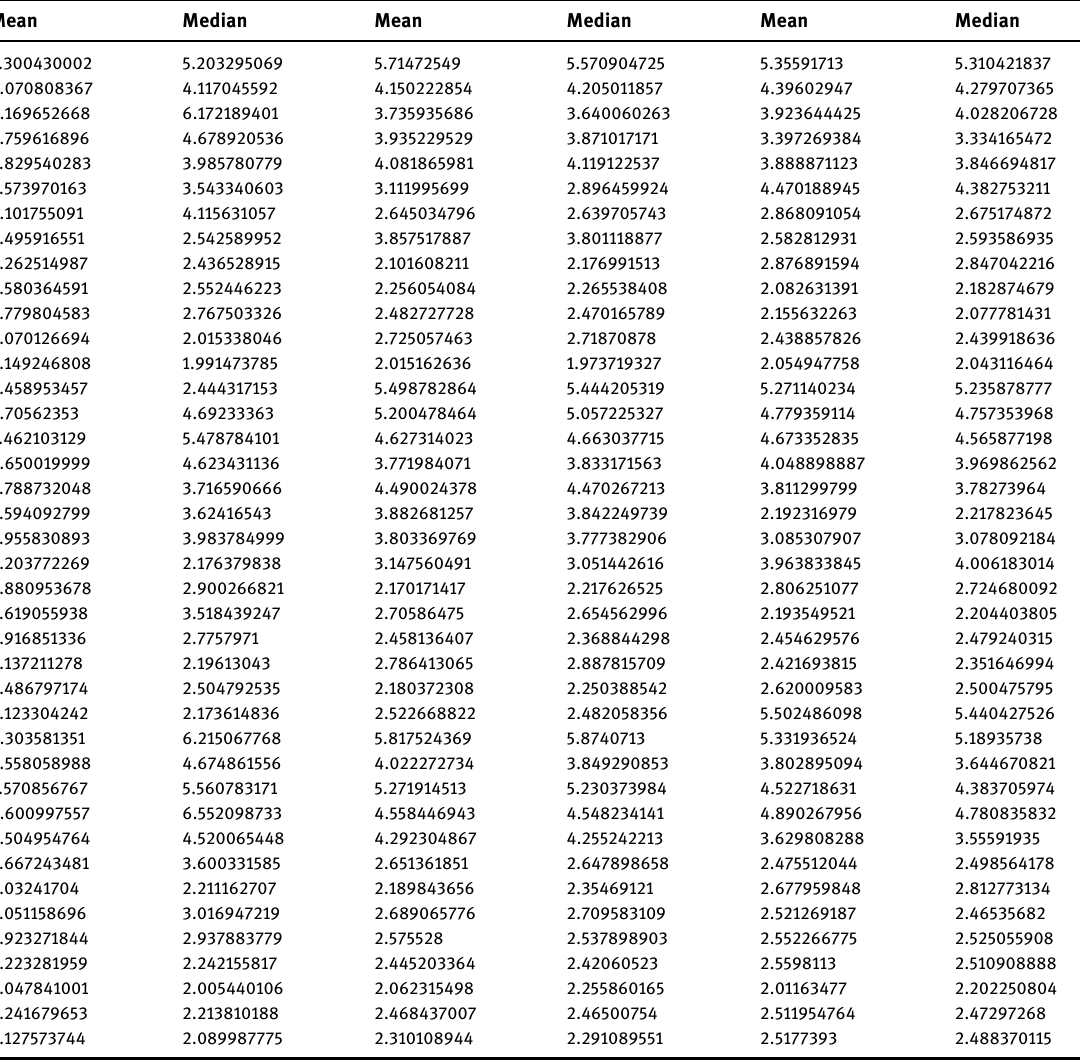
Table 3: Sample of ten maximum values of r th for 1,000 replications of generalized ESD test